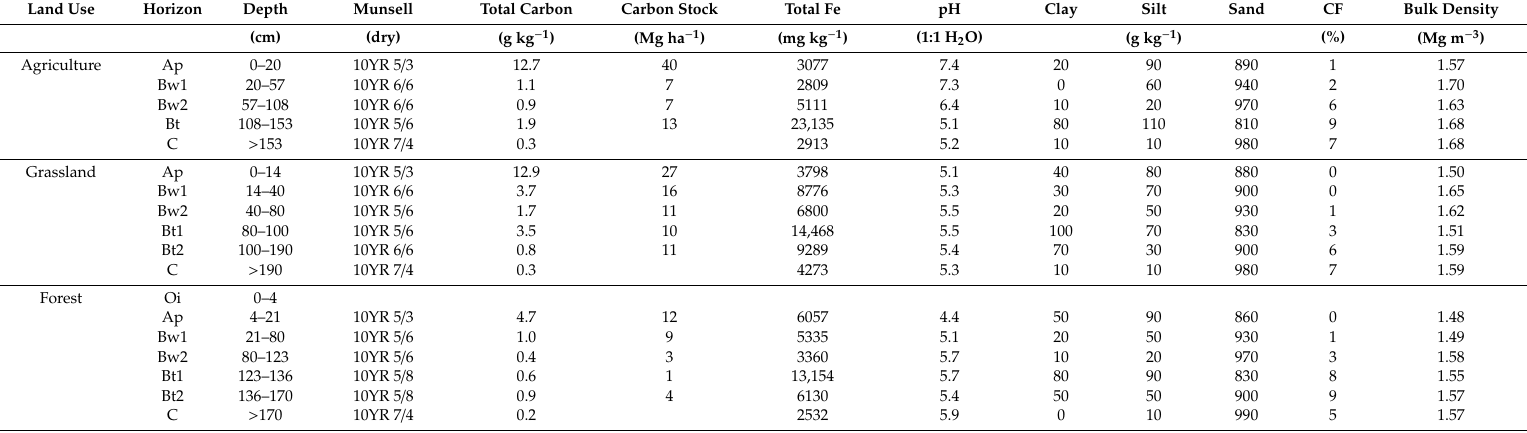
Carbon stocks were corrected for coarse fragments; CF = coarse fragments; Total Fe from CDB